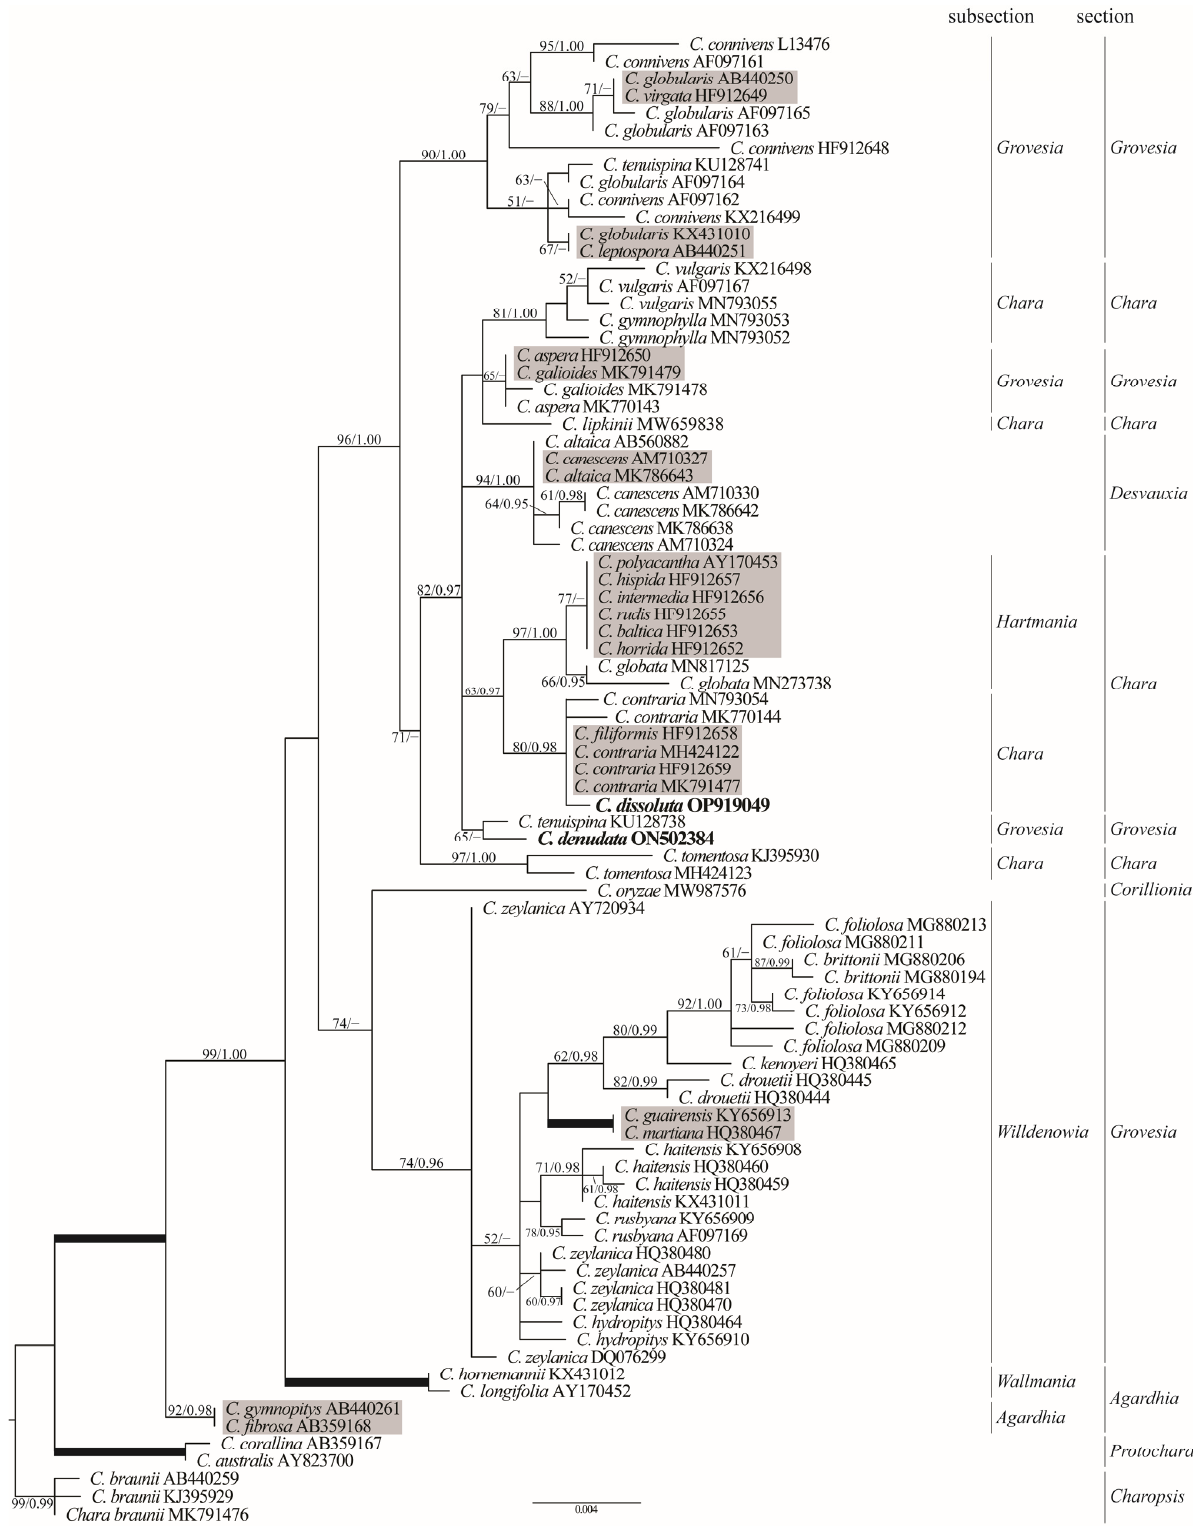
Figure 6. Maximum likelihood phylogenetic tree inferred in PAUP with the GTR+I+G nucleotide substitution model from 86 rbc L sequences of Chara . ML BP (>50%) and BI PP (>0.95). Branches received 100% BP and 1.00 PP support, and the newly obtained sequences are shown in bold. Sequences of the different species carrying one genotype are marked with grey. Chara sections and subsections are based on [2] with changes from [13,46].